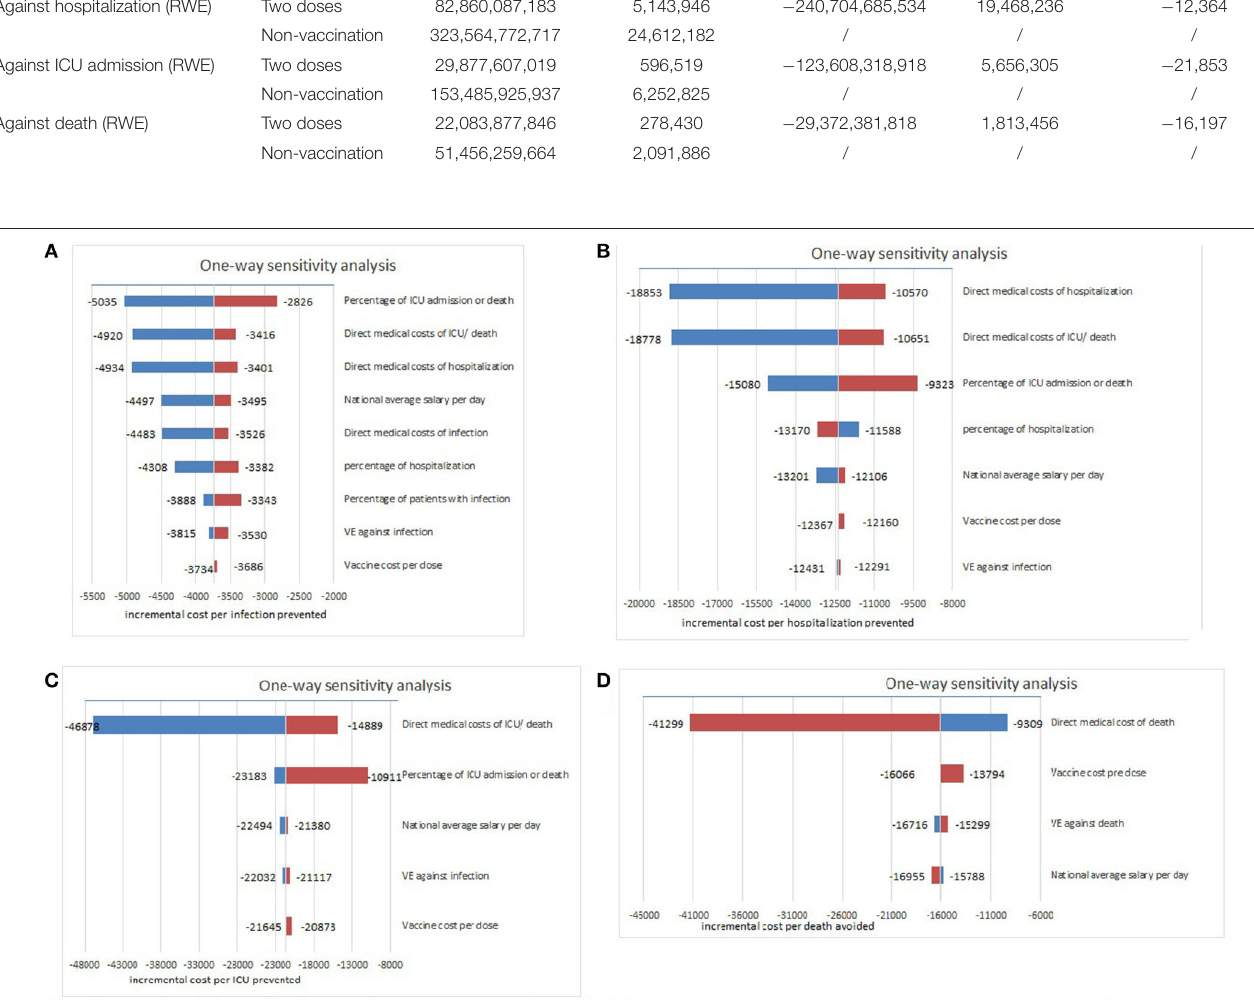
FIGURE 4 | One-way sensitivity analyses for the model on ICER (US$/event). (A) Sensitivity analysis for model against COVID-19 infection, (B) Sensitivity analysis for model against COVID-19 hospitalization, (C) Sensitivity analysis for model against COVID-19 ICU admission, (D) Sensitivity analysis for model against COVID-19 related